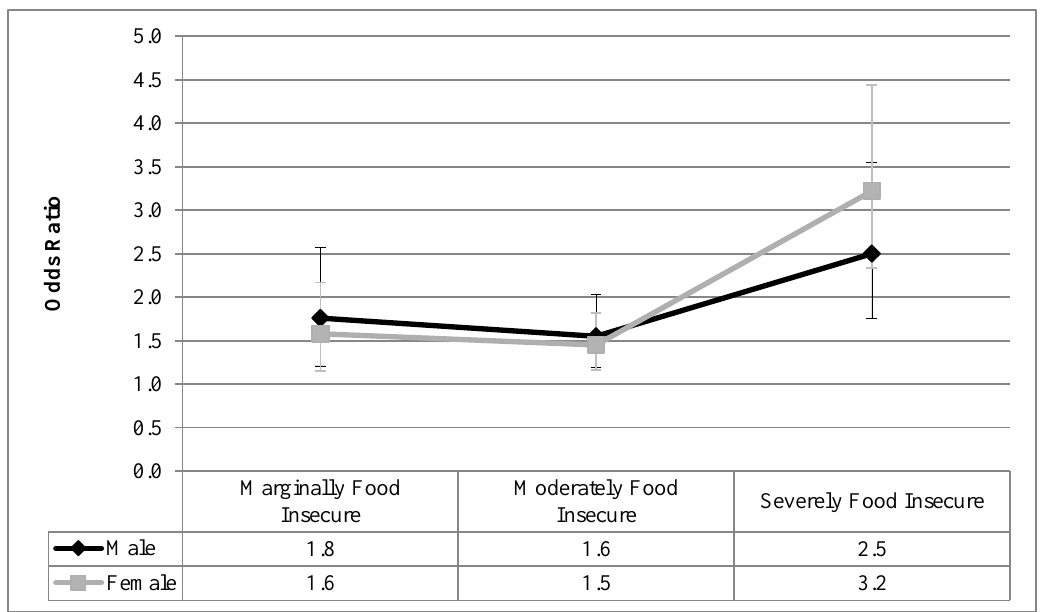
Figure 3. Odds ratio of reporting mood disorders for each level of household food insecurity stratified by sex, compared with food secure; results from reduced binary logistic regression.